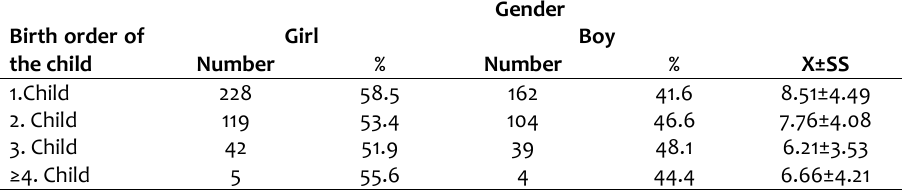
Table 2 . The distribution of gender and age average by number of children